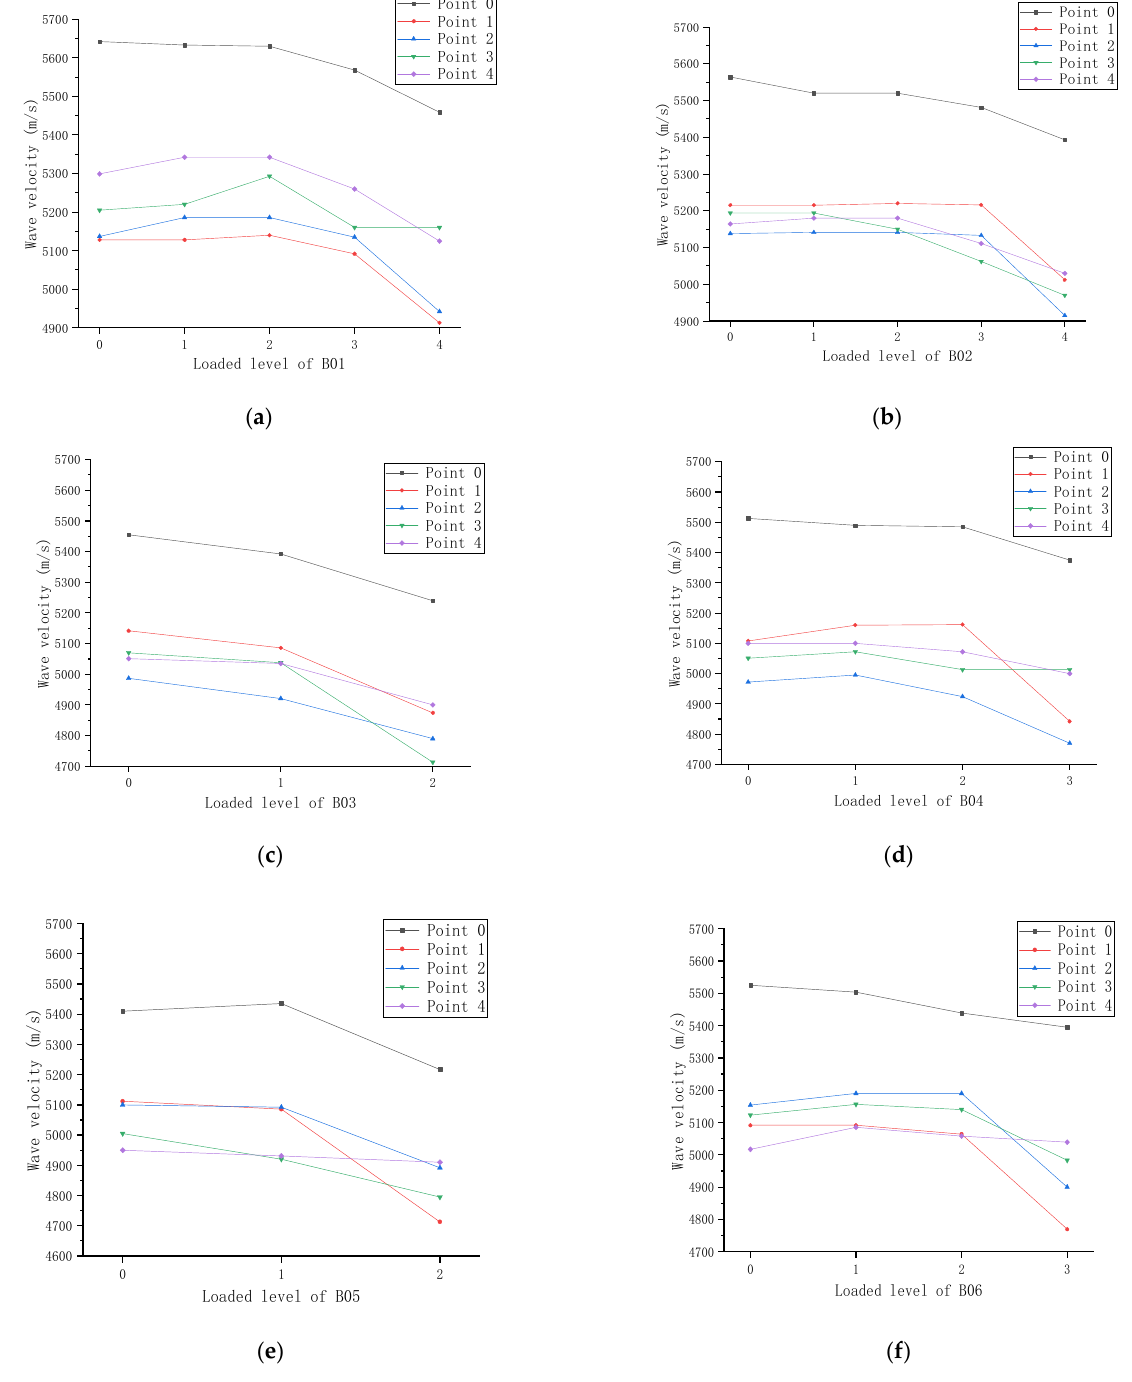
Figure 17. Uniaxial loading and unloading levels of rock samples and changes of point wave velocity. ( a ) Wave velocity change of rock sample B01; ( b ) Wave velocity change of rock sample B02; ( c ) Wave velocity change of rock sample B03; ( d ) Wave velocity change of rock sample B04; ( e ) Wave velocity change of rock sample B05. ( f ) Wave velocity change of rock sample B06. After the second level unloading, the wave velocities of B01, B02, B04, and B06 re ‐ main basically unchanged, but the wave velocities of individual points increase or de ‐ crease, because the rock is heterogeneous, and there is certain variability in the structure and density changes of various points in the rock. After the third level unloading, the wave velocities of B01, B02, B04, and B06 de ‐ crease at almost all points, and the relative decrease in wave velocities of B04 and B06 is more obvious. It shows that the unloading of this level has caused damage to the interior of the two rock samples, and the internal cracks are obviously developed and damaged. After the 4th stage unloading, the wave velocities of B01 and B02 decrease signifi ‐ cantly, indicating that further crack development and expansion continued to occur in the samples, and these samples were finally destroyed in the loading stage of the 5th level cycle. In terms of axial wave velocity, the axial wave velocity of the six samples after loading and unloading at all levels decreases, because the initiation and development of radial cracks enhances the reflection of ultrasonic waves in the axial direction, thus re ‐ ducing the axial wave velocity of the samples. It can be concluded that the development of radial cracks in rock samples is driven by any level of unloading and loading.